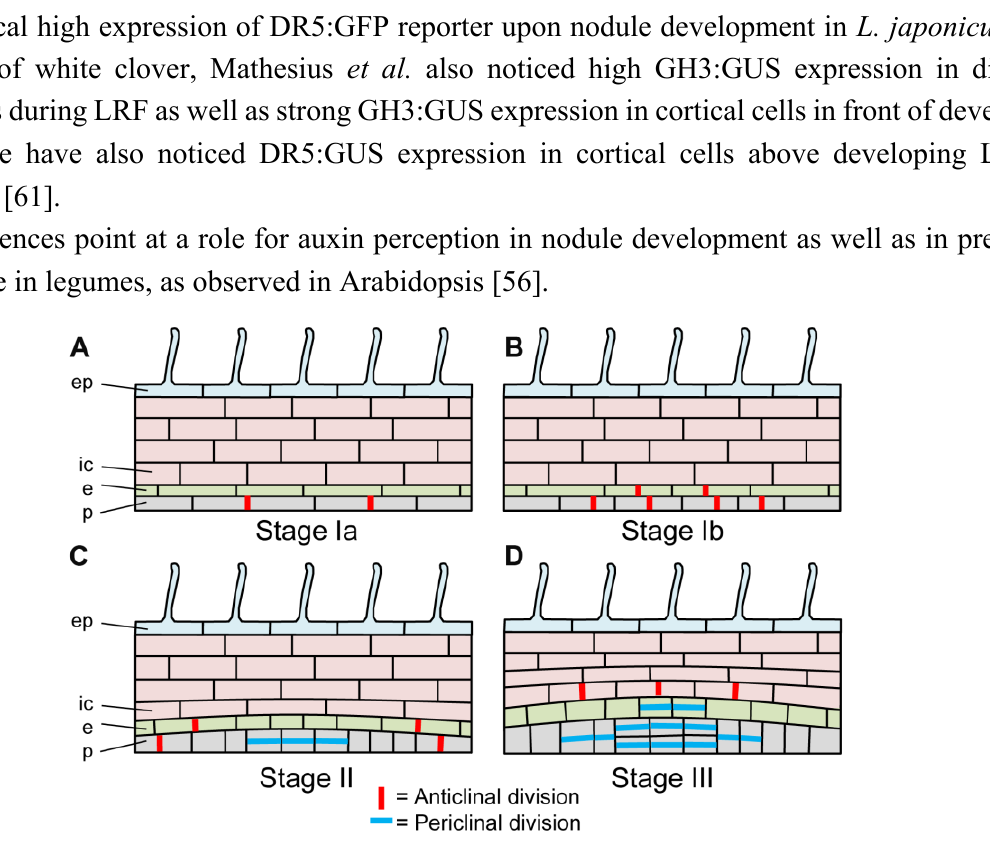
Figure 3. Schematic representation of the early developmental stages of lateral root formation in Medicago truncatula . Scheme of longitudinal sections in the main root of M. truncatula during LRF, showing the main type of cell divisions but not the precise number of dividing cells. ( A ). Stage Ia. Anticlinal divisions in the pericycle; ( B ). Stage Ib. Anticlinal divisions in the endodermis and the pericycle; ( C ). Stage II. Periclinal divisions in the pericycle and anticlinal divisions in the endodermis and the pericycle; ( D ). Stage III. Periclinal divisions in the endodermis (two cell layers) and the pericycle (four cell layers), and anticlinal divisions in the inner cortex. p: pericycle; e: endodermis; ic: inner cortex, ep: epidermis. From